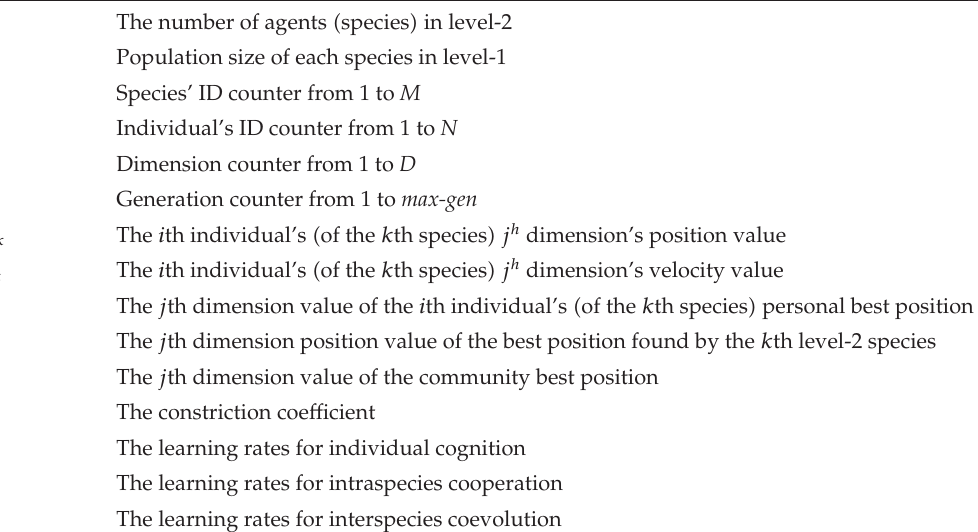
Table 2: Parameters of the PS 2